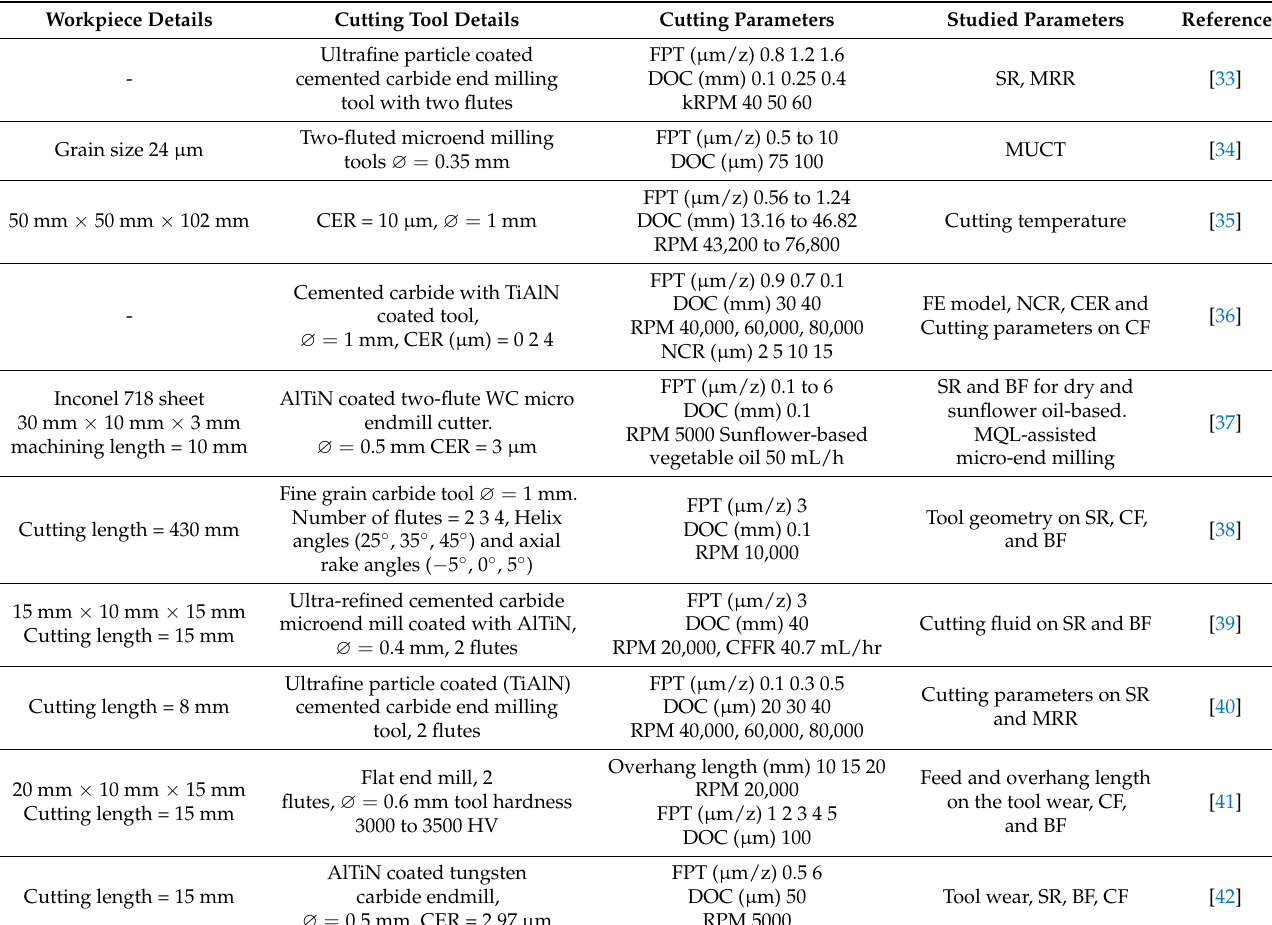
Table 1. Summary of past studies on micromachining of Inconel 718